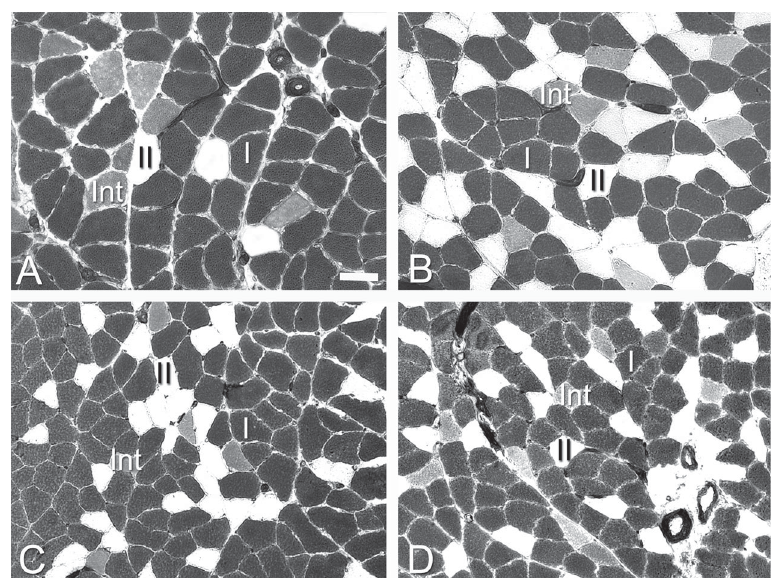
Figure 1. Histochemical ATPase activity at pH 4.39 of a representative soleus muscle from the control group (A), the cyclosporin-A-receiving group (B), the immobilized group (C), and the immobilized group receiving cyclosporin-A (D). I, II and Int denote type I, type II and intermediate fibers, respectively. Solid bar = 50 µm for all panels.